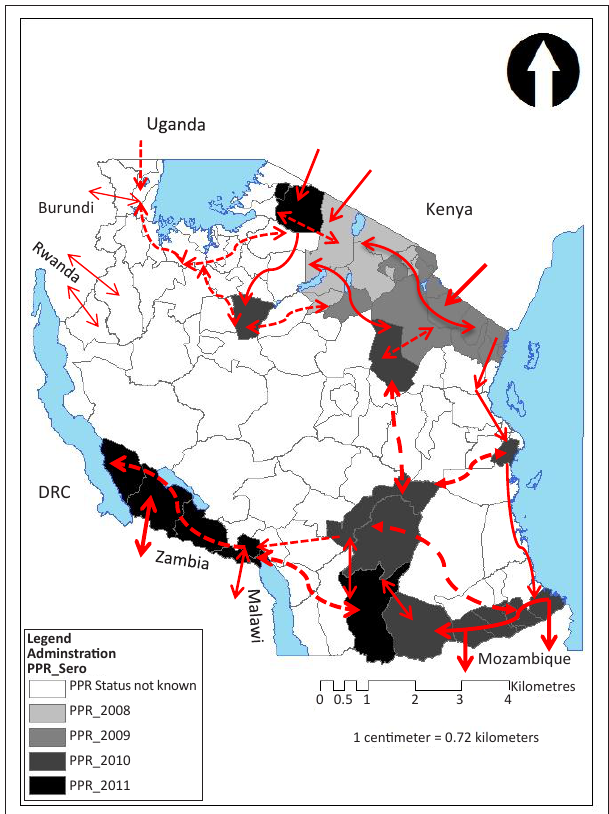
FIGURE 1: Chronology and spread of peste des petits ruminants in Tanzania.